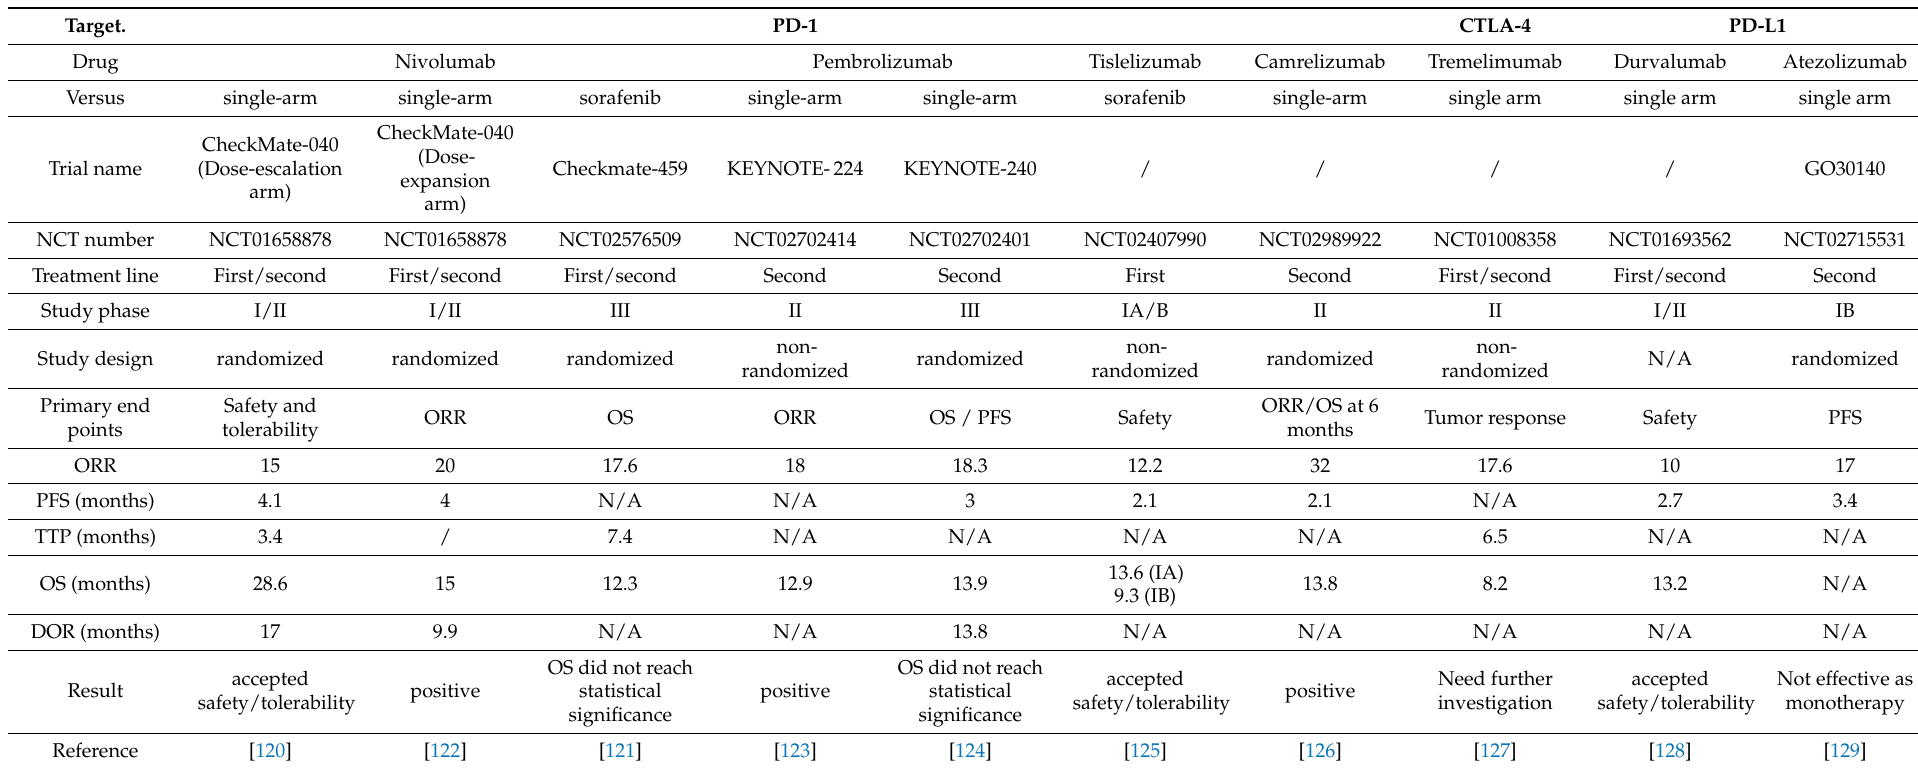
Table 2. Clinical trials for immune checkpoint inhibitors as monotherapy in Hepatocellular carcinoma.